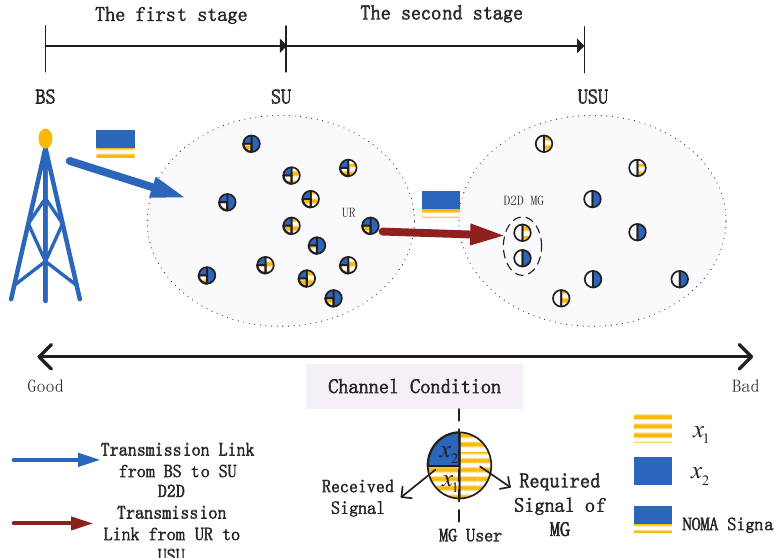
Figure 1. System model of cooperative multicast (COM)-based non-orthogonal multiple access (NOMA). One circle represents a multicast group user. The right side area represents the required signal. When the required signal is x 1 or x 2 , this user belongs to MG 1 or MG 2 separately. The left side area represents user’s reception signal. When the left side area is filled with NOMA signaling, this user is a successful user (SU). Otherwise, the user is an unsuccessful user (USU). From the perspective of received NOMA signaling, two MGs are regarded one quasi-multicast group